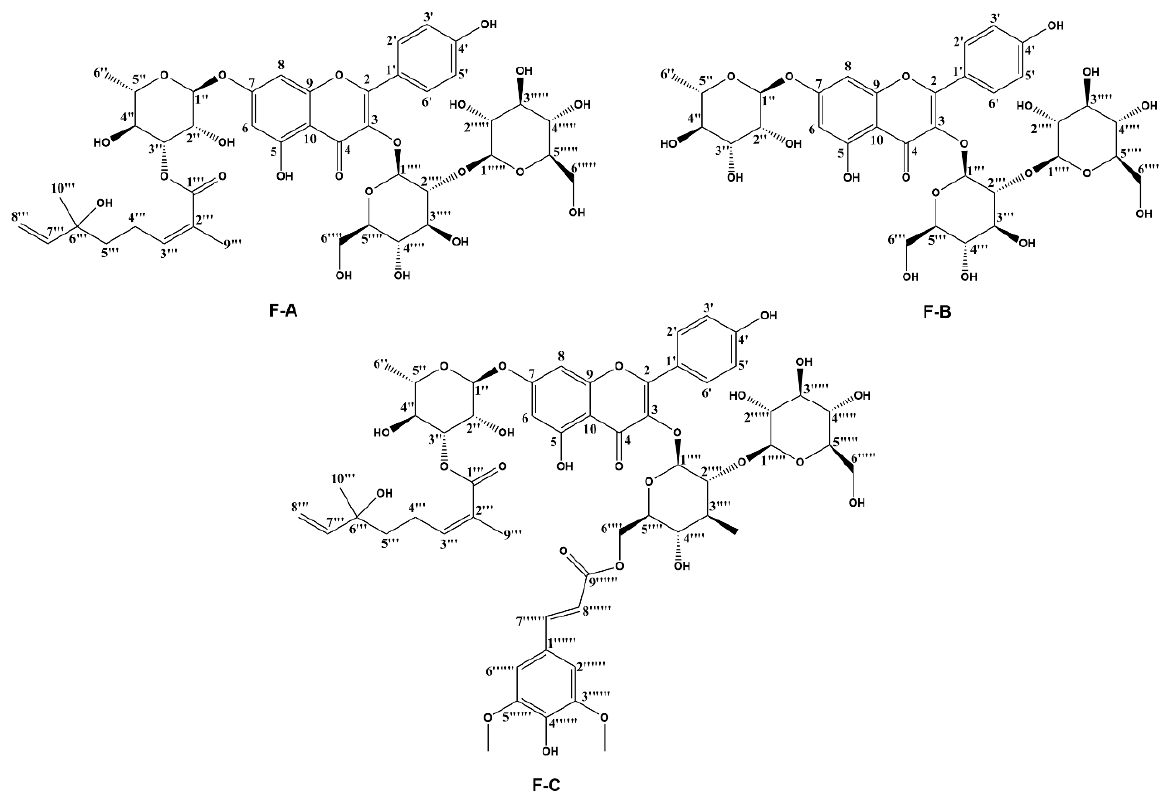
Figure 1. Chemical structures of three flavonoids (F-A, F-B, and F-C) from Hippophae rhamnoides L.